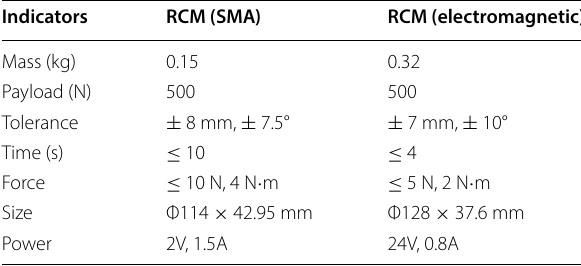
Table 4 The indicators of the two